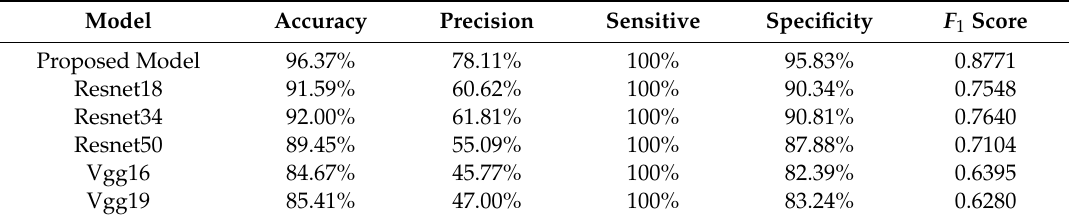
Table 6. Evaluation of several models.